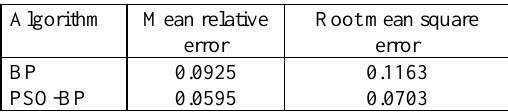
Figure 4 . Results comparison between BP algorithm and PSO- BP algorithm